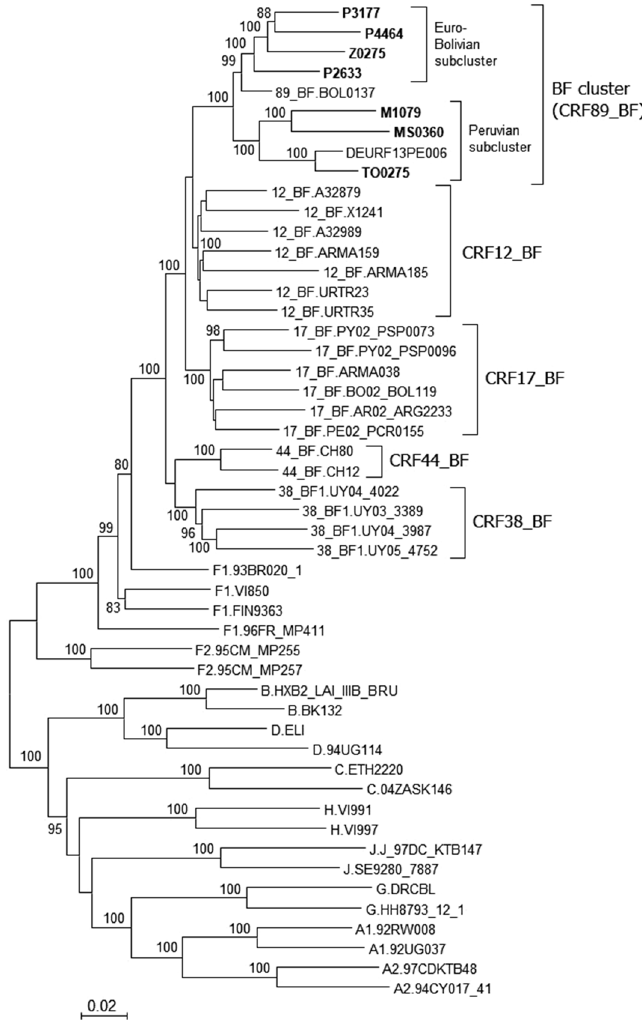
database sequences located in the BF cluster, the country of sample collection is indicated before the virus name with the two-letter ISO country code. In reference sequences, the subtype or CRF is indicated before the virus name. Only bootstrap values ≥ 80% are